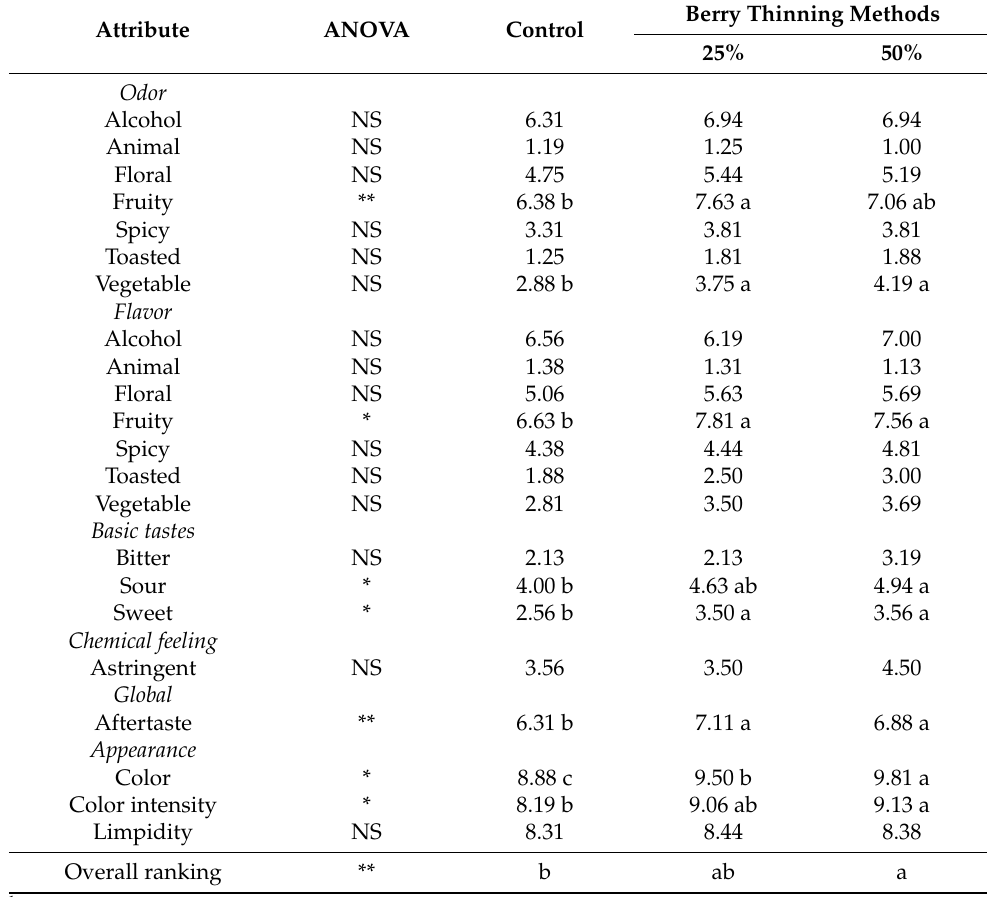
Table 3. Descriptive sensory analysis and consumer acceptance of wines made from grapes for control,25%, and 50% of berry thinning methods in the 2019 growing season 1